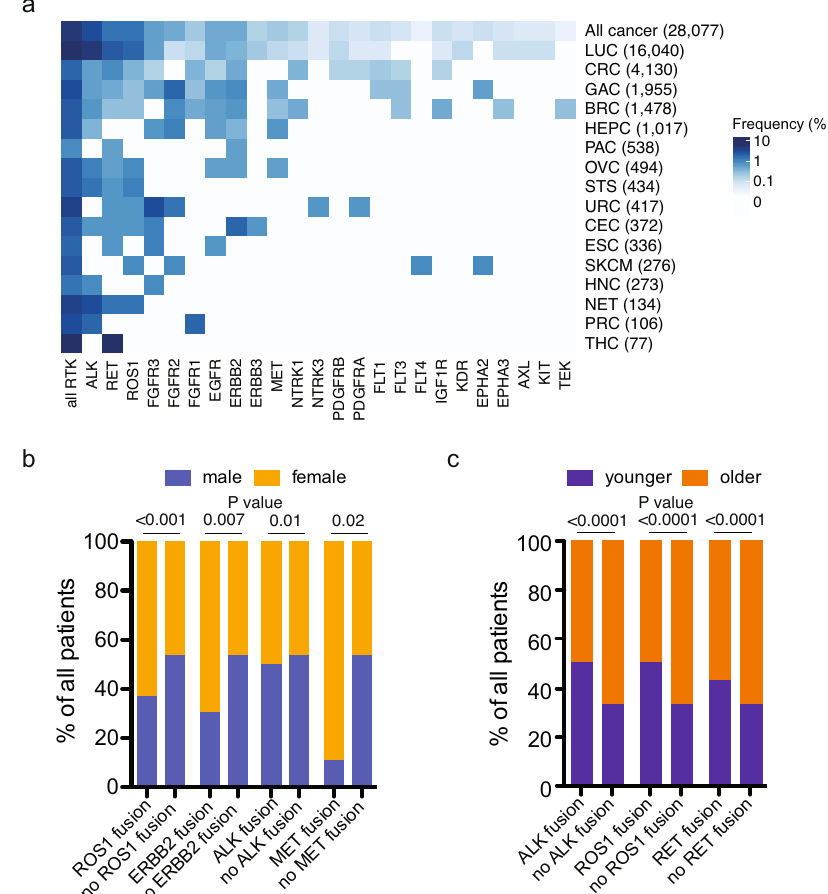
Fig. 1 Landscape of RTK fusions across diverse cancers. a Heatmap showing the prevalence of rearrangements of speci fi c RTKs in different cancers, LUC lung cancer, CRC colorectal cancer, GAC gastric cancer, BRC breast cancer, HEPC hepatobiliary cancer, PAC pancreatic cancer, OVC ovarian cancer, STS soft tissue sarcoma, CEC cervical cancer, ESC esophageal cancer, URC urinary cancer, HNC head and neck cancer, SKCM skin cutaneous melanoma, NET neuroendocrine tumor, PRC prostate cancer, THC thyroid cancer. b ROS1 , ERBB2 , ALK , and MET fusions showed increased associations with the female sex. c ALK , ROS1 , and RET fusions showed increased associations with younger